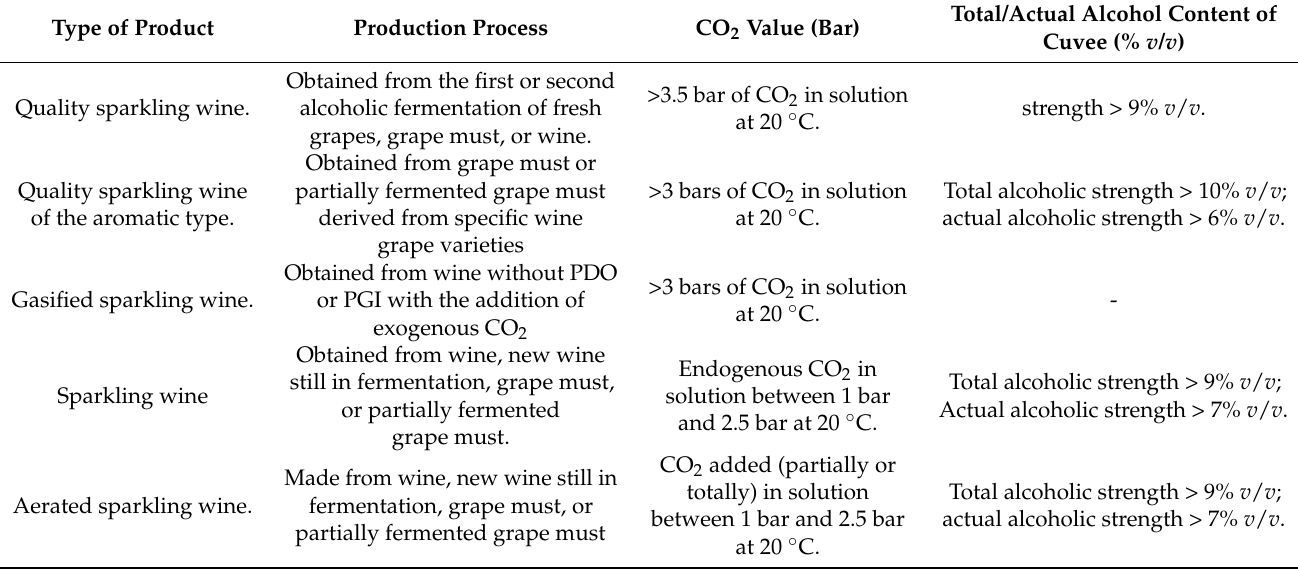
Table 1. Legislative classification of sparkling wines according to EU Reg. 1308/2013, (Regulation (EU) No 1308/2013 of the European Parliament and